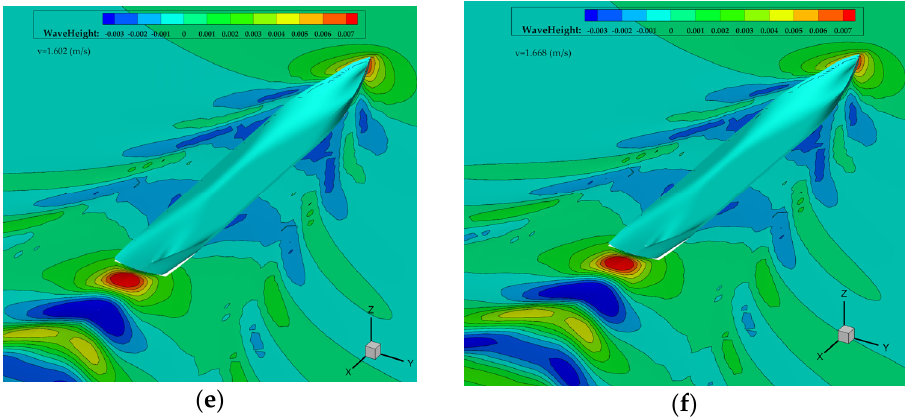
Figure 9. Wave height generated for all speeds—perspective view (Tecplot): ( a ) v = 1.335 m/s; ( b ) v = 1.401 m/s; ( c ) v = 1.469 m/s; ( d ) v = 1.535 m/s; ( e ) v = 1.602 m/s; ( f ) v = 1.668 m/s.